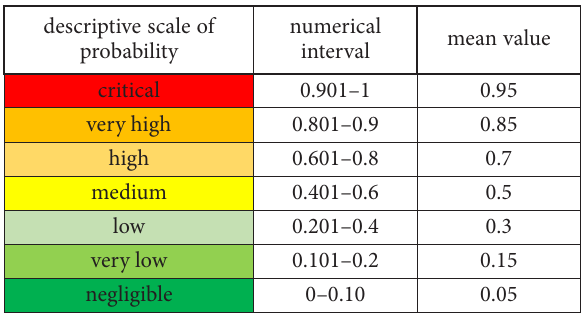
Table 3. Descriptive scale adopted for